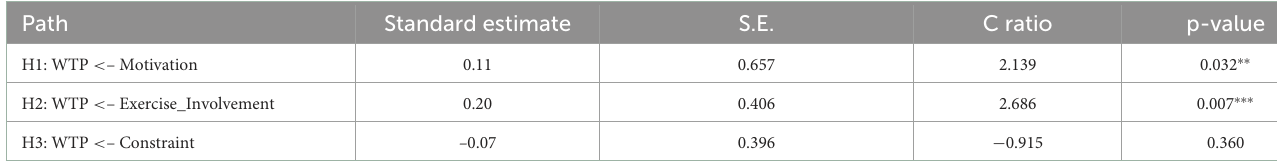
TABLE 8 The result of SEM and hypothesis. Path Standard